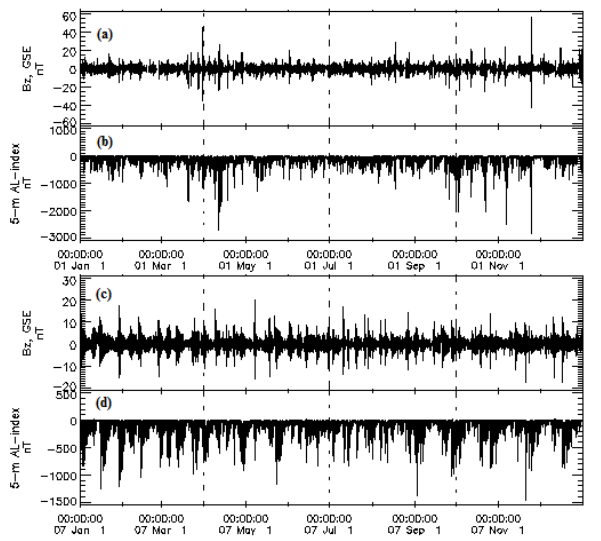
Fig. 1. The component B z of IMF and auroral electrojet index AL for the years 2001 (panels (a) and (b)) and 2007 (panels (c) and (d)). The dashed vertical lines mark the three-month periods or quarters.